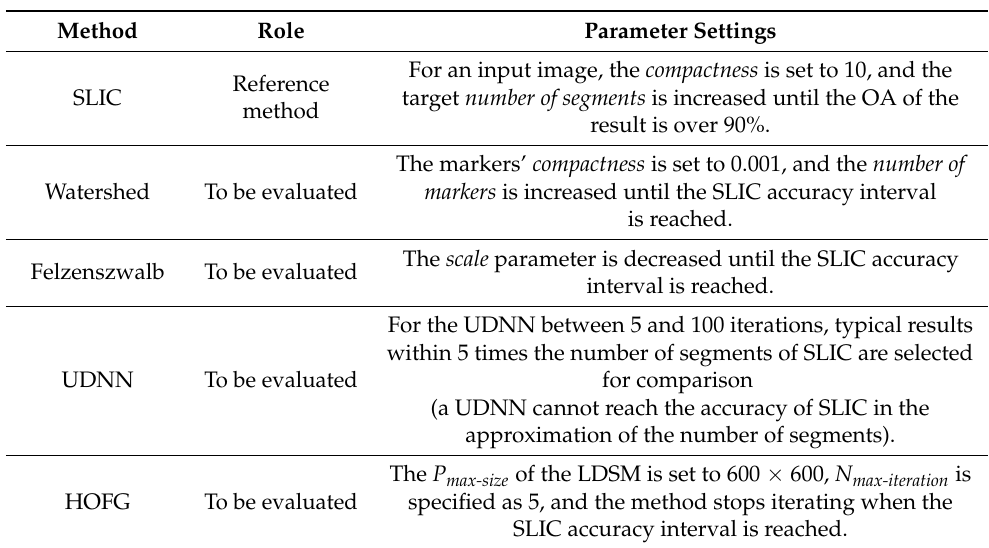
Table 2. Parameter settings for all